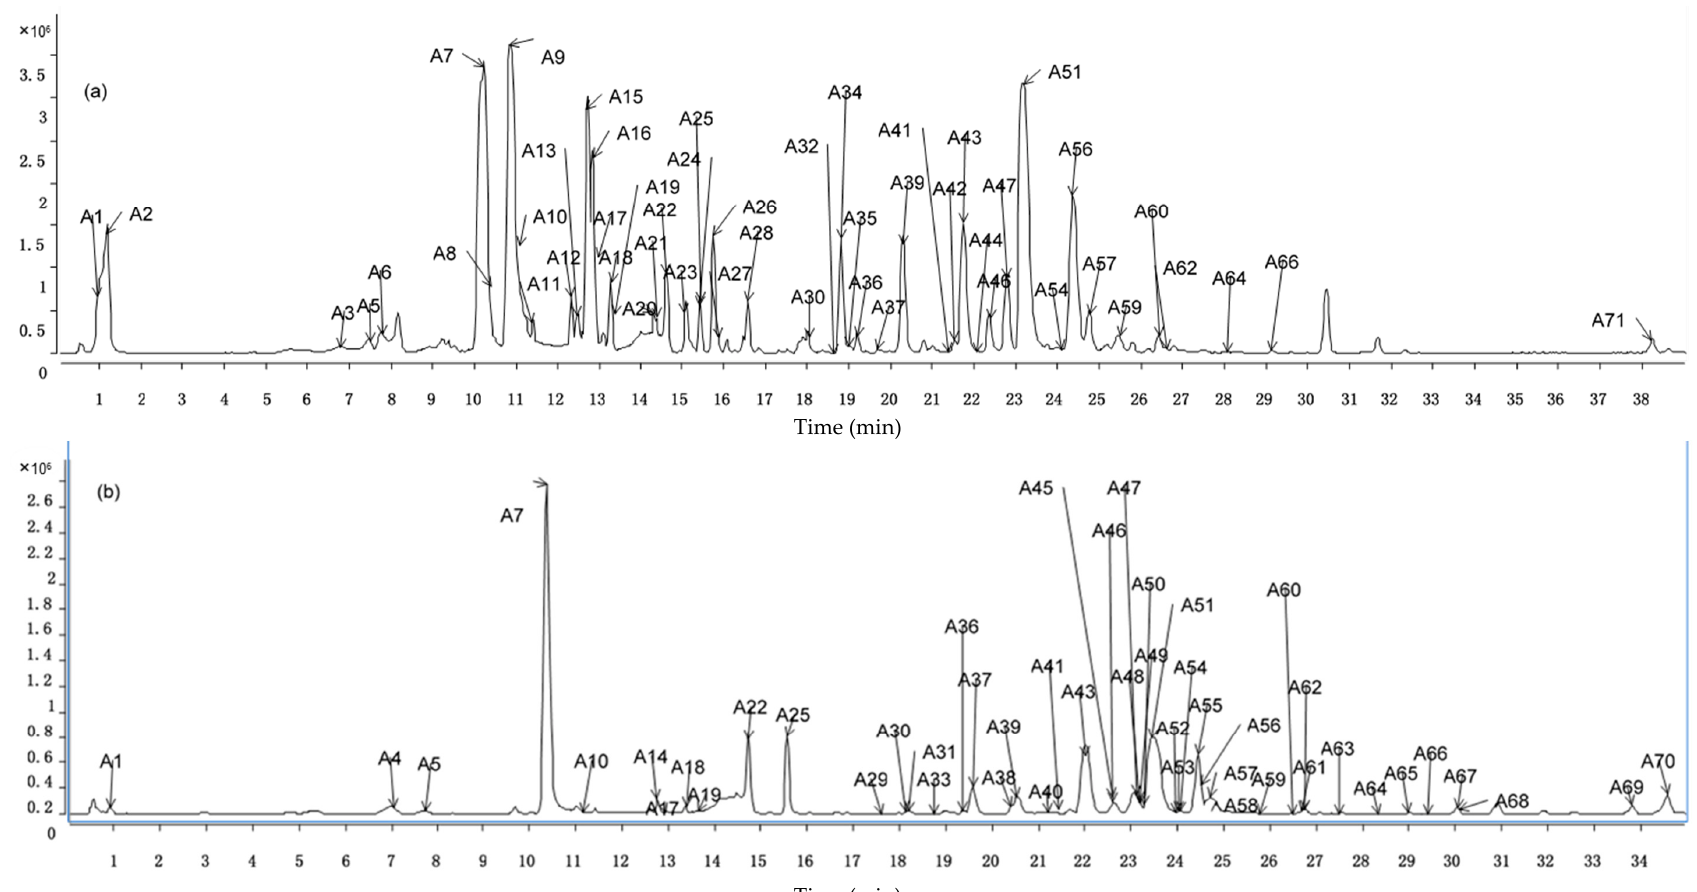
Figure 1. Rapid resolution liquid chromatography with quadrupole-time-of-flight mass spectrometry (RRLC-Q-TOF-MS) chromatograms of prepared Guizhi decoction (GZD). ( a ) Total ion chromatograms in negative mode; ( b ) Total ion chromatograms in positive mode.